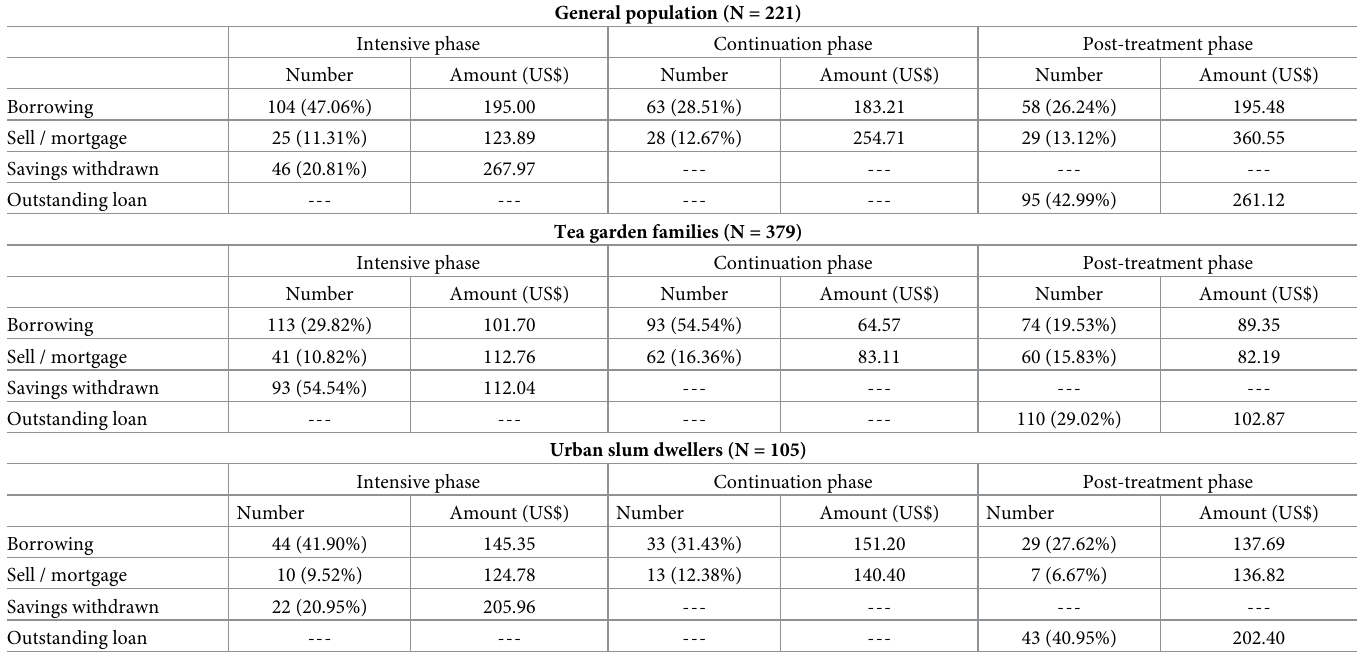
Table 4. Coping strategies during treatment and post-treatment period.